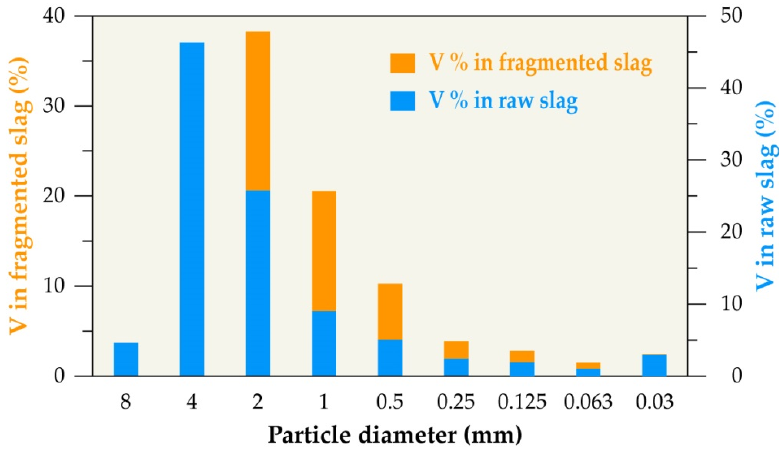
Figure 4. Vanadium distribution in different particle size fractions of raw and fragmented slag.